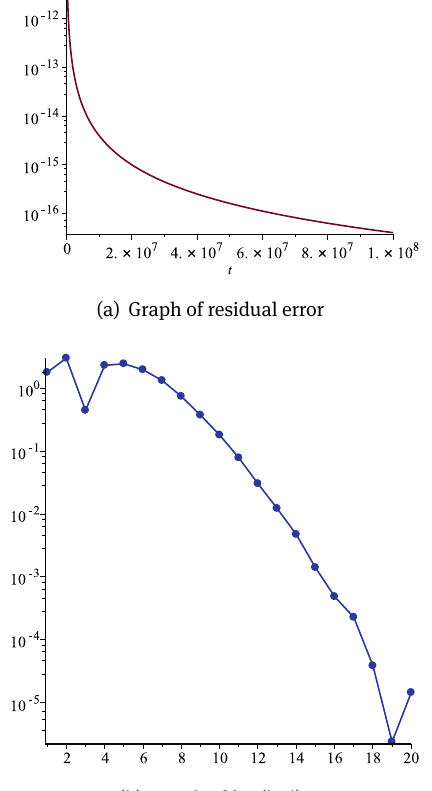
(b) Graph of log ( | a i | ) Fig. 4: Obtained graphs of residual error and the logarithm of coeffi- cients | a i | for b 1 = 0.60 and b 2 = 0.50 , to show the convergence of the